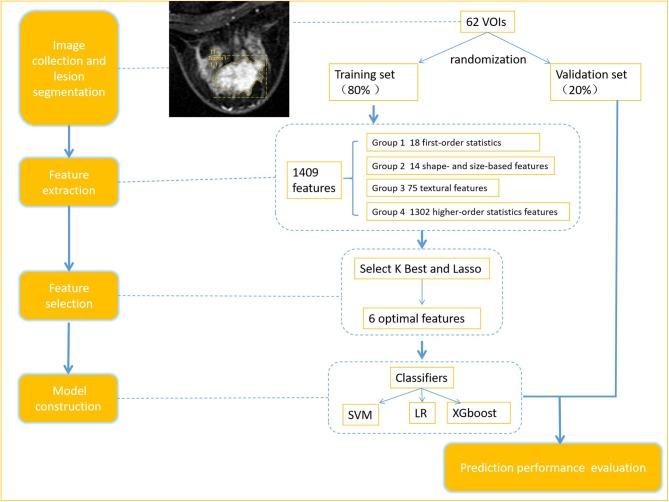
Radiomics workflow.